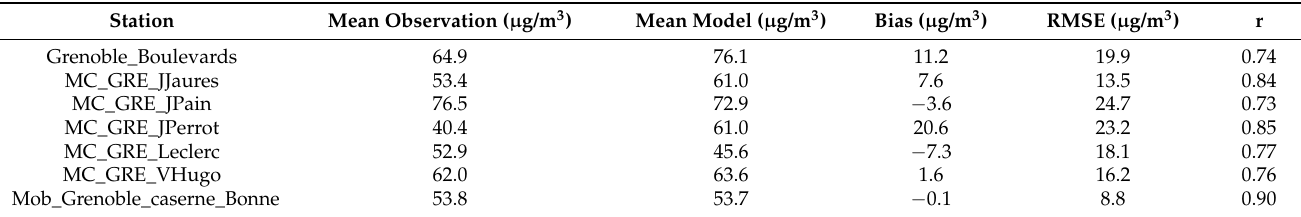
Figure 4. Time series of observed and computed concentration of NO 2 at Grenoble_boulevards station between the 25th of January 2017 and the 31st of January 2017. PMSS NO 2 results are compared to SIRANE results obtained by Atmo AURA over the same computation period with strictly the same input data (emissions, meteorology, and background concentrations) (see Figure 5). Only the first vertical level of the PMSS model is compared to the concentrations of the SIRANE model, which correspond more by construction to spatial averages within each street.